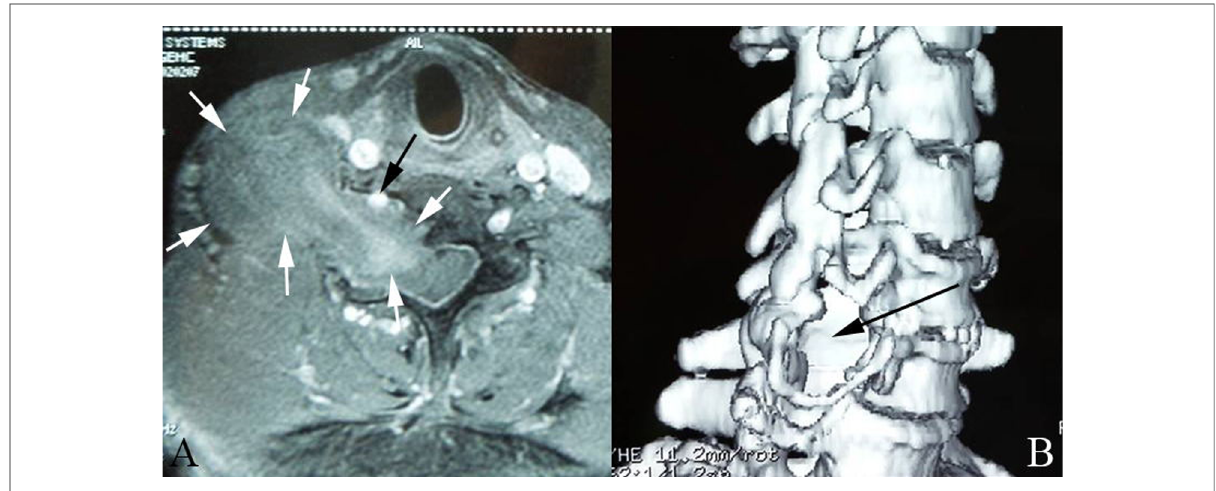
FIGURE 1 ( A ): the vertebral artery was displacedanteriorly and partially encircled by the tumor. White arrow: tumor; Black arrow:vertebral artery ( B ): Three- dimensional CT reconstruction shows intervertebral foramen was obviously enlarged (black